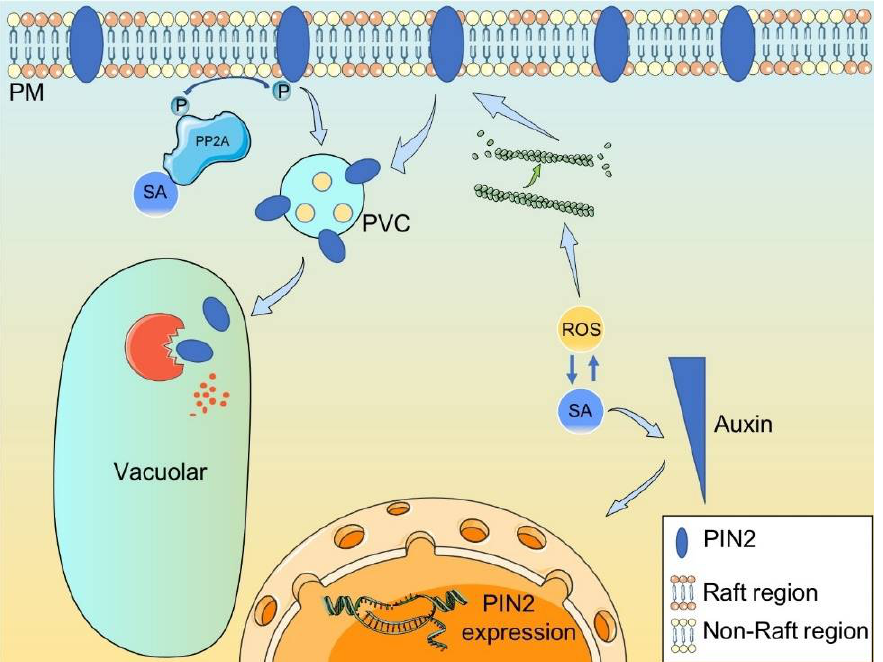
Figure 6. A speculative model of SA regulated auxin transport. High SA directly inhibits the transcription of PIN2 and induces the compartmentalization of membrane nanodomain, which restricts the lateral diffusive movement of PIN2. SA also binds to PP2A, which in turn affects the phosphorylation of PIN2. The constrained lateral movement of PIN2 causes its clustering and suppressed endocytosis independent of the clathrin-mediated membrane trafficking pathway. SA also cross-talks with ROS, which affects the actin dynamics to modulate ARF-GEF-dependent trafficking of PIN2. Finally, PIN2 is sorted from the plasma membrane to the vacuoles.